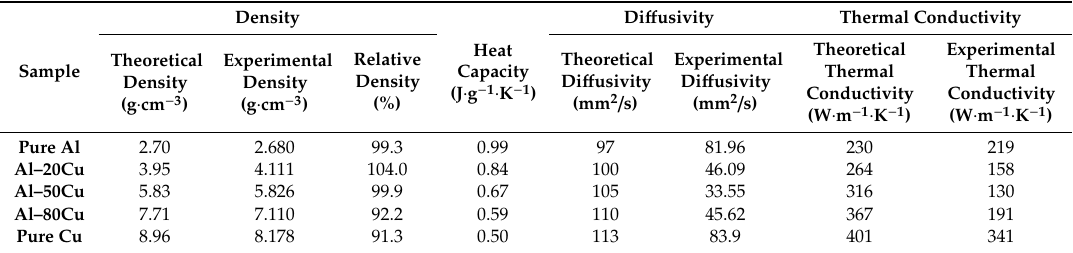
Table 2. Thermal properties and densities of Al, Cu, and Al–Cu composites at room